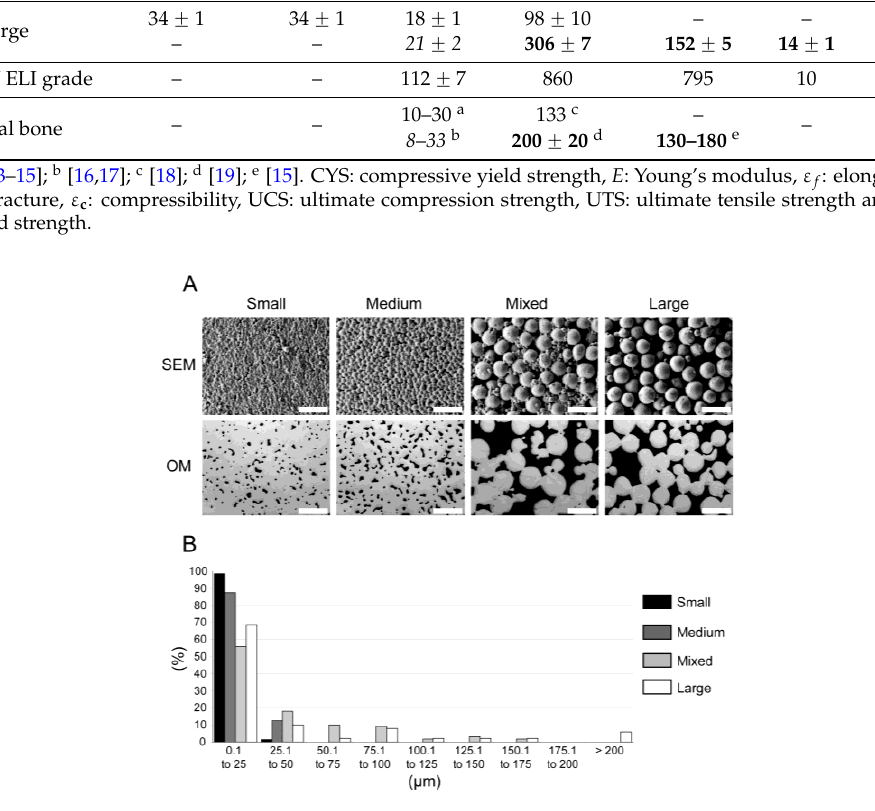
Figure 1. Material characterization (adapted from [11]). ( A ) Material Images. Scanning electron microscopy (SEM) and optical microscopy photographs (OM) of Small, Medium, Mixed, and Large materials (scale bar 200 µm). ( B ) Pore sizes. Distribution of the pore sizes (in µm) for each material: Small, Medium, Mixed, and Large in black, dark grey, light grey, and white, respectively.